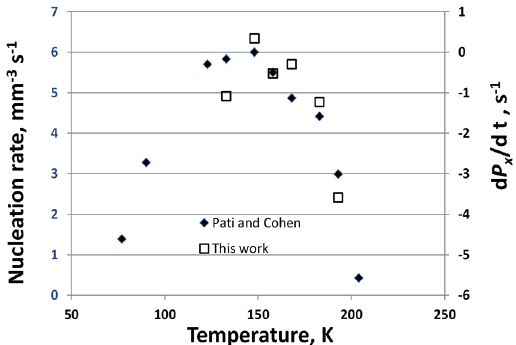
Figure 4: Comparison of temperature variation of the rate of autocatalytic transformation, dP / dt , with that of the initial rate of X the isothermal martensite transformation in Fe-24wt%Ni-3wt%Mn 34 .